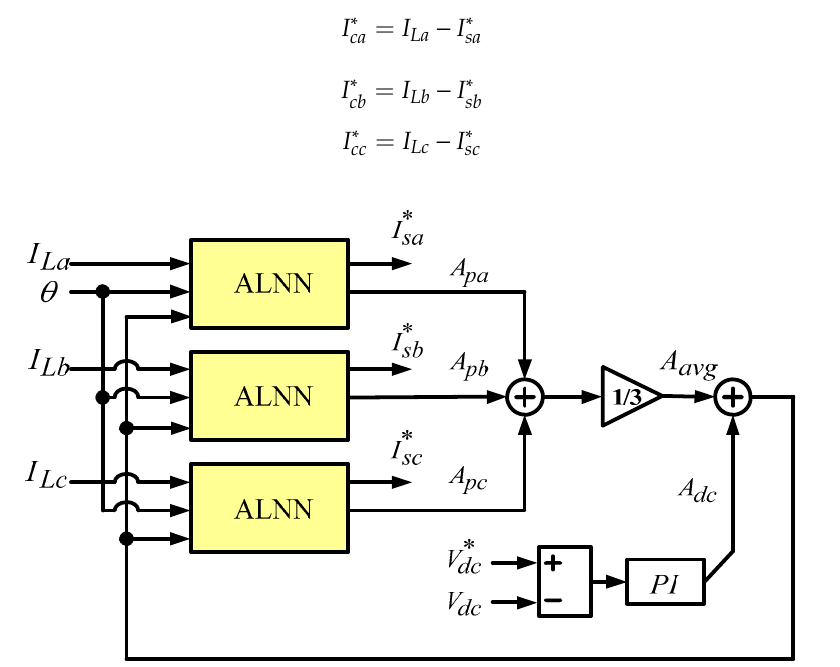
Figure 4. Block diagram of proposed ALNN-based reference compensation current control strategy.